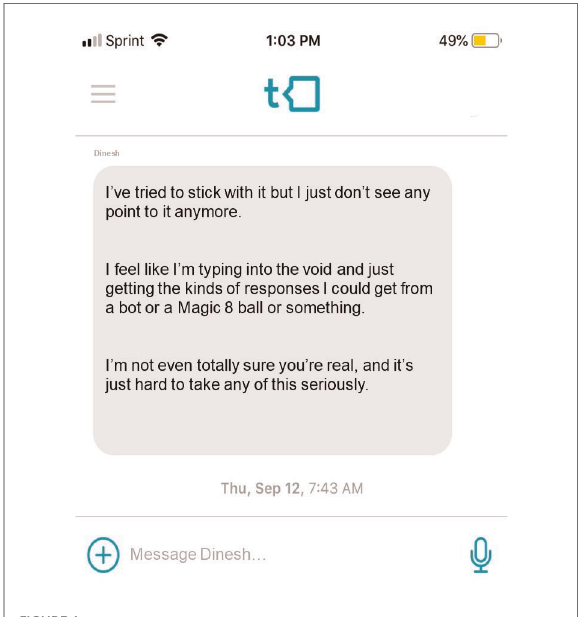
FIGURE 1 An example vignette from the FIS-T performance task. The FIS-T Task-taker is shown this message and then writes an appropriate